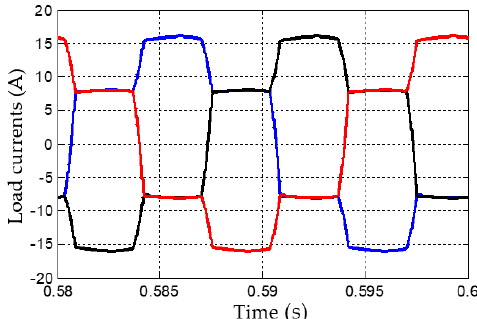
Figure 6. Waveforms of load currents in steady-state regime.